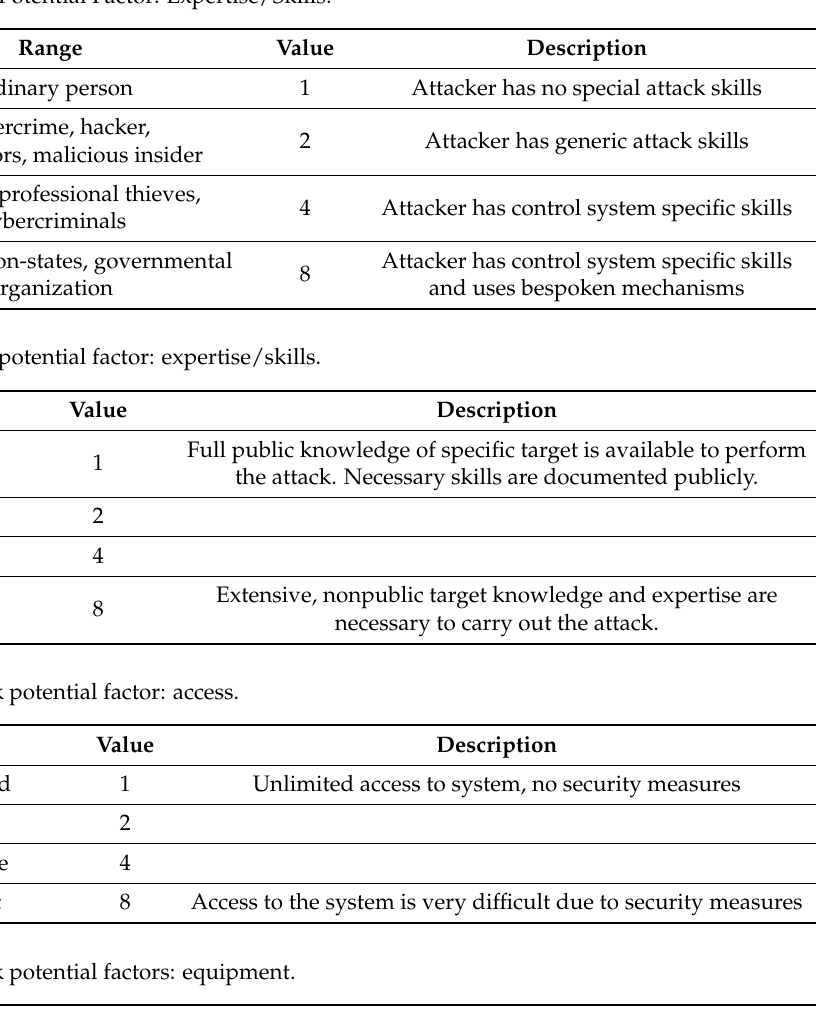
Table 8. Attack Potential Factor: Expertise/Skills.